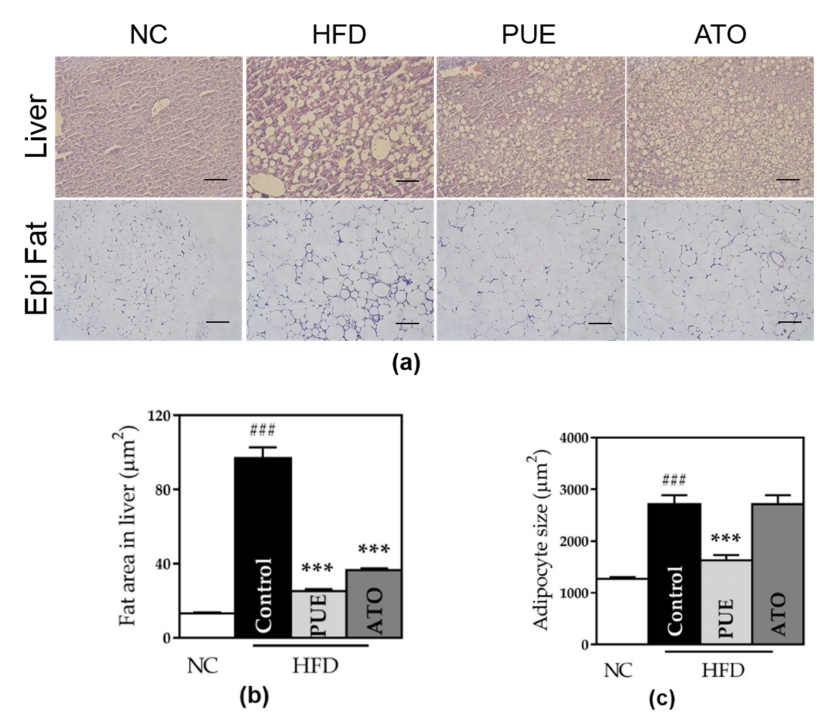
Figure 7. Analysis of tissue microscopic results. ( a ) Histological images of liver and epididymal